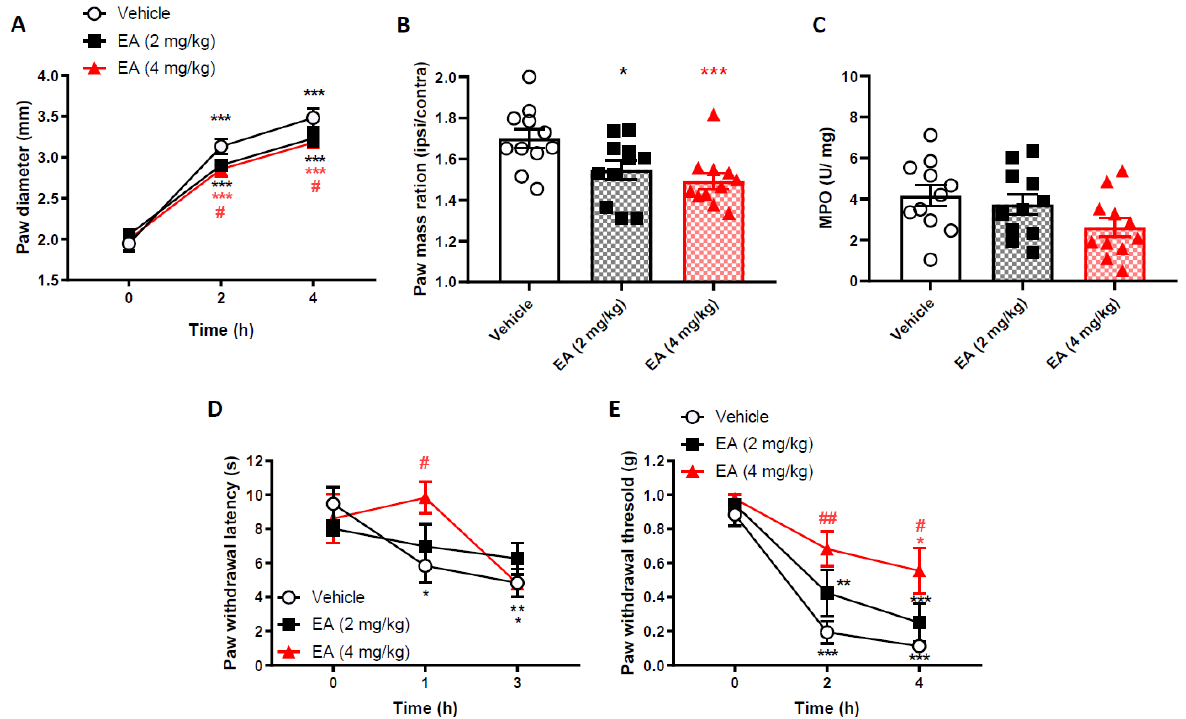
Figure 1. Englerin-A given as a pretreatment reduces carrageenan-induced paw oedema and mechanical and thermal hyper- algesia, in a dose-dependent manner. ( A ) Time-course of paw oedema diameter measured by callipers and ( B ) ipsilateral/ contralateral paw mass ratio 4 h following induction of paw oedema 2% Carrageenan. Data are mean ± S.E.M, n = 11. * p < 0.05, *** p < 0.001 versus baseline, # p < 0.05, versus vehicle, Two-way Repeated measures (RM) ANOVA, post-hoc Tukey test. ( C ) Myeloperoxidase (MPO) levels in paw exudates, 4 h after the induction of paw inflammation. Data are presented as mean ± S.E.M, n = 11. ( D ) Thermal and ( E ) mechanical paw withdrawal thresholds measured at baseline and at 1 and 3 or 2 and 4 h, respectively, after intra-plantar injections of carrageenan in the left hindpaw. * p < 0.05, ** p < 0.01, *** p < 0.001 versus baseline, # p < 0.05, ## p < 0.01 versus vehicle, Two-way RM ANOVA, post hoc Tukey test. Data are mean ± S.E.M, n = 8 (Hargreaves test: n =